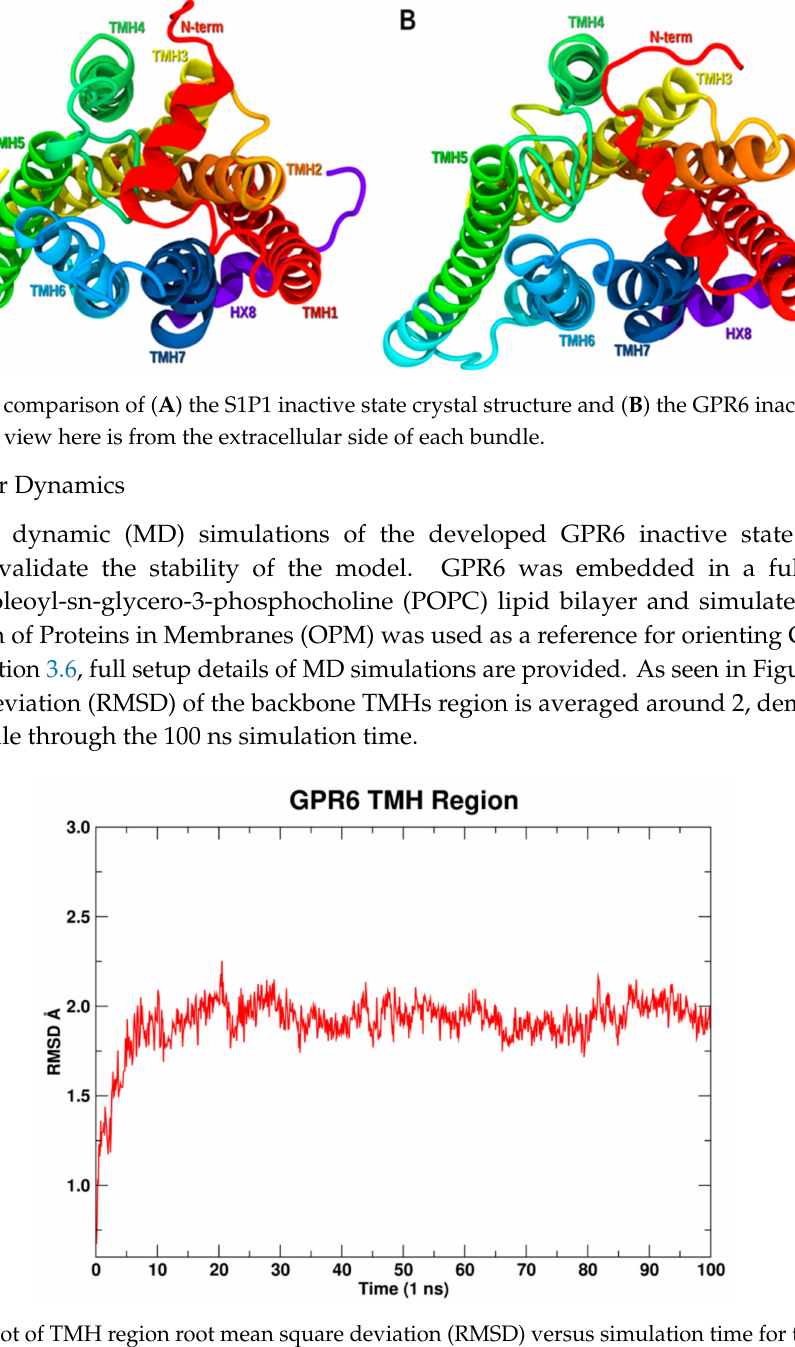
Figure 4. Plot of TMH region root mean square deviation (RMSD) versus simulation time for the GPR6 inactive state